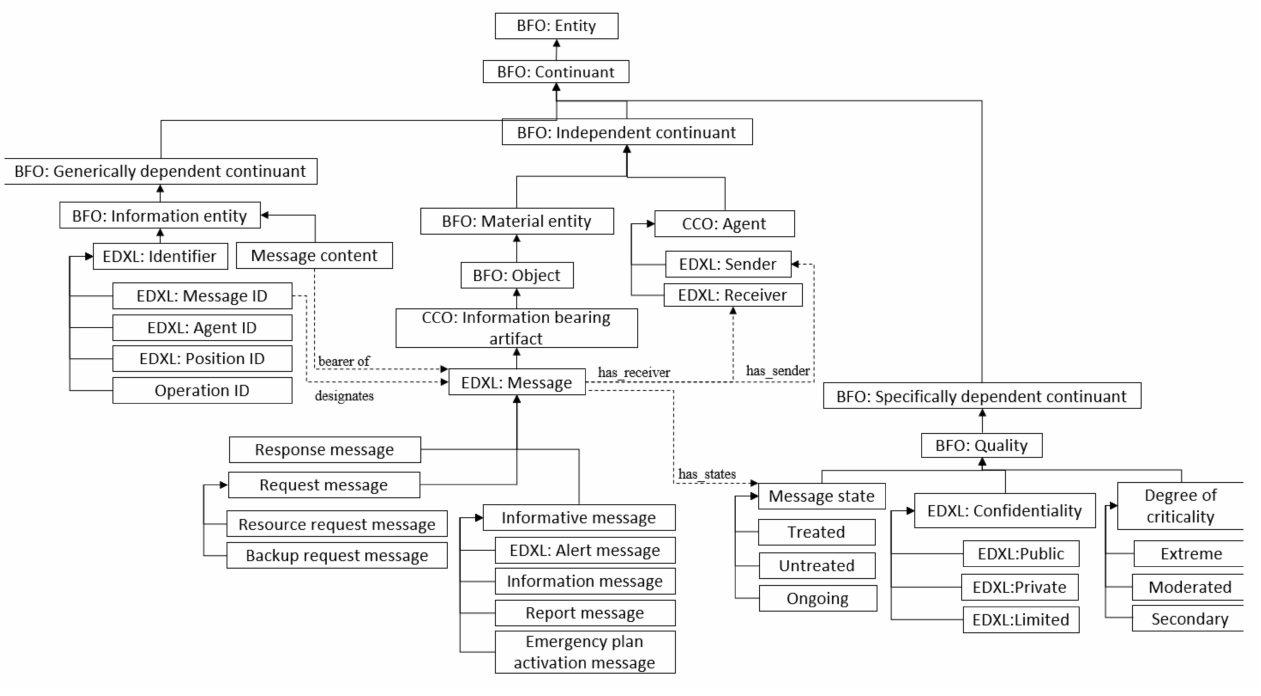
Figure 15. Message module. Table 5. Classes and relations of